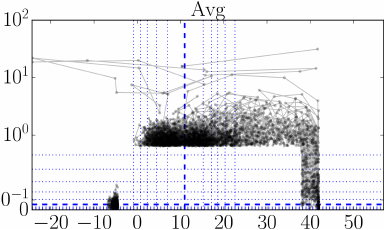
Figure 6. Illustrative plots for visually identifying outliers (see text for an explanation): FINO1 72m ambient temperature data ( ◦